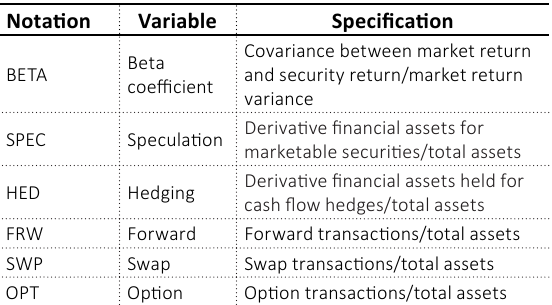
Table 1. Variables used in the